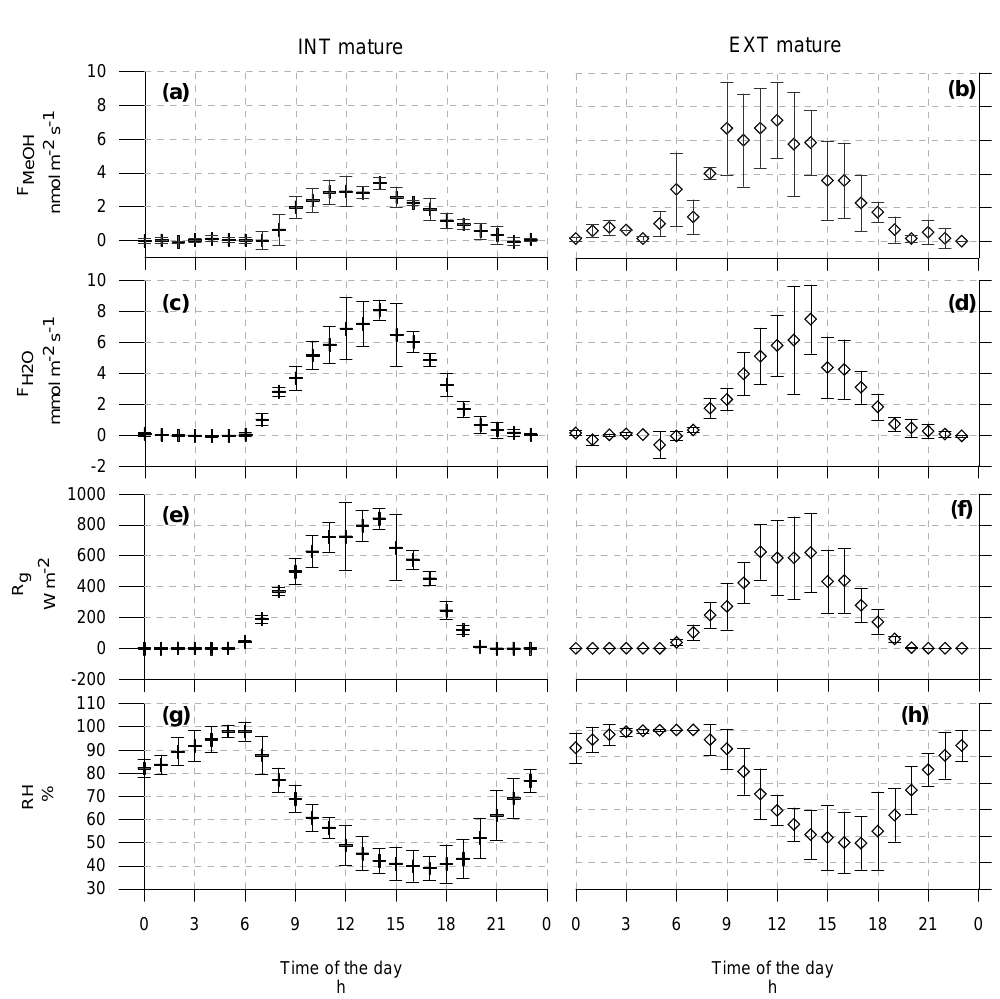
Fig. 8. Mean hourly values of the mature phase of the intensive (left, +) and the extensive field (right, ♦ ): (a, b) methanol flux ( F MeOH ) ; (c, ) ; (e, f) global radiation ( R g ) ; (g, h) relative humidity (RH). Error bars are the standard d) water vapour flux ( F H 2 O